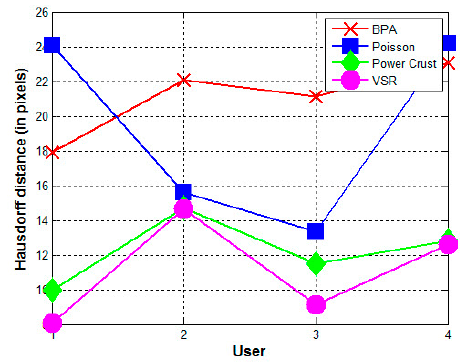
Figure 11. Hausdorff distances between the reconstructed surfaces and the original surface (HUMAN KIDNEY). The contours were drawn by four different users. Table 3. Difference between the reconstructed surface and the original surface (HUMAN KIDNEY; the contours were drawn by different users).